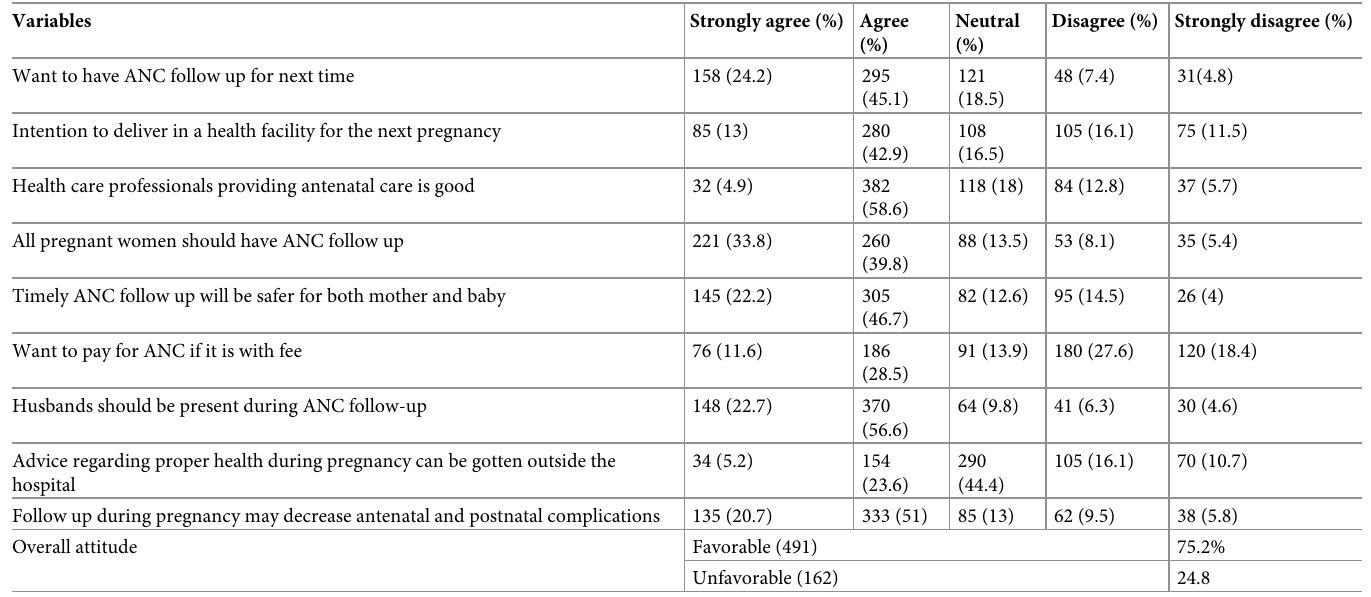
Table 4. Attitude towards antenatal care uptake by component among women delivered at home in rural Sehala Seyemit district, northern Ethiopia, 2020 (n = 653). Variables Strongly agree (%) Agree